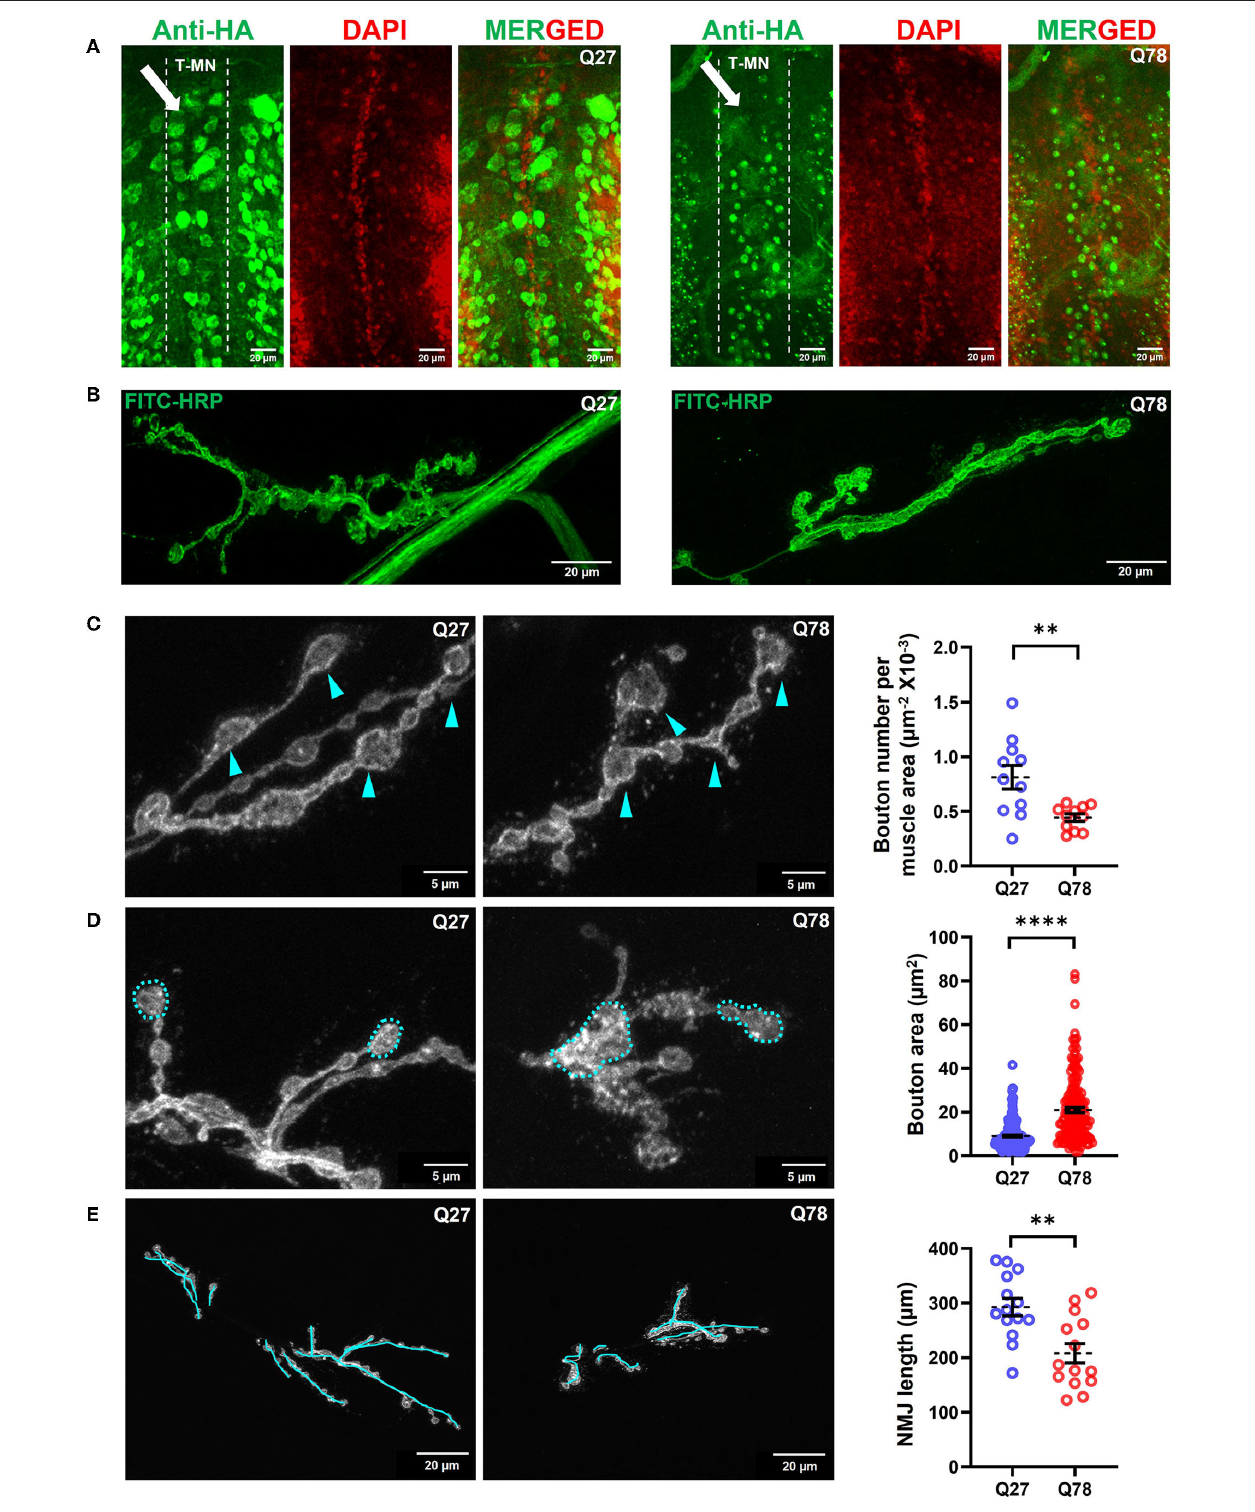
FIGURE 3 | Q78 expression in motor neurons leads to multiparametric changes in the morphology of NMJs. (A) An image depicting the cell bodies of motor neurons in the ventral nerve cord (VNCs) of Drosophila larvae. An arrow depicts the alignment of the thoracic motor neuron (T-MN) cell bodies. FITC-HRP marks the neuronal membrane. HA antibody was used for staining the pathogenic or non-pathogenic ATXN3 polyQ protein. (B) Image depicting the NMJs of the third instar larva